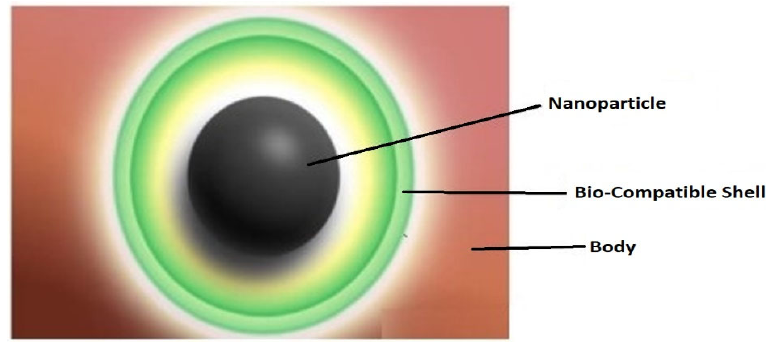
Figure 4. Biocompatible shell for nanoparticles.